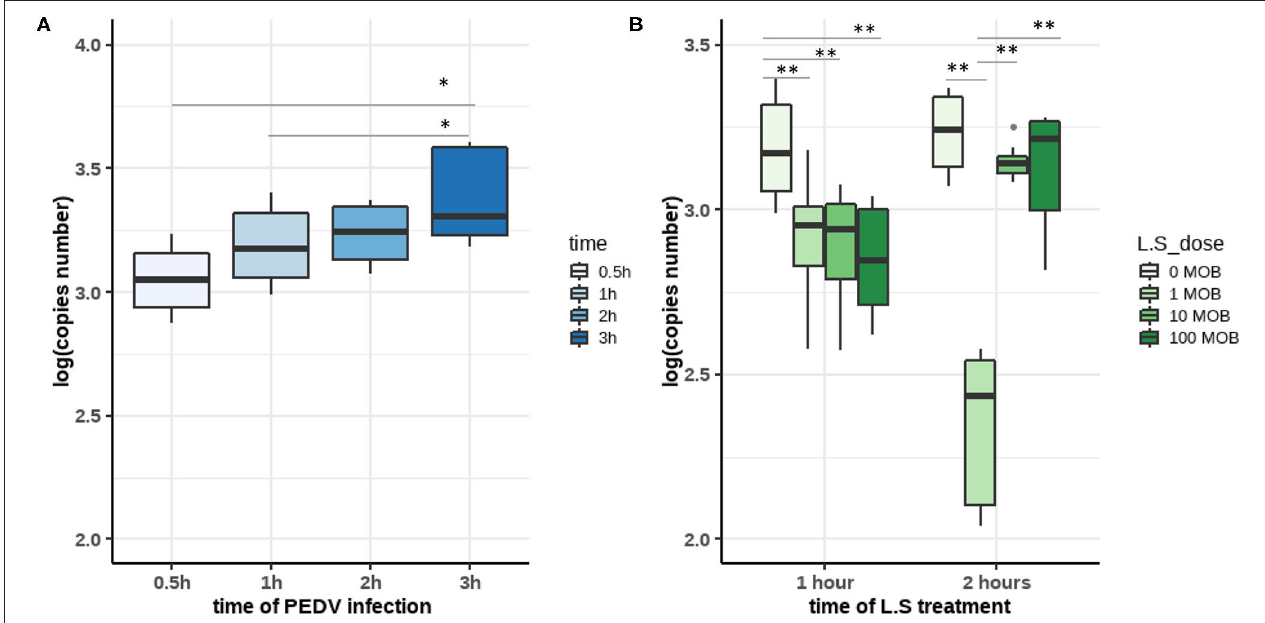
FIGURE 5 | (A) The copy numbers of porcine epidemic diarrhea virus (PEDV) in infected IPEC-J2 cells at different time points. IPEC-J2 cells were infected with the PEDV CV777 strain at 0.1 MOI. After 0.5h, 1h, 2h, and 3h of incubation, viral copies were quantified by qPCR. (B) Lactobacillus salivarius inhibits the infection of IPEC-J2 cells by PEDV. IPEC-J2 cells were treated with different concentrations of L. salivarius (1, 10, and 100 MOI) for 2h before PEDV infection. Then, IPEC-J2 cells were infected with PEDV CV777 at 0.1 MOI for 1 or 2h. The copy numbers of PEDV in each group were detected by qPCR. The differences between the groups were analyzed using the Kruskal–Wallis test. Significant differences are marked with asterisks. *: p < 0.05, **: p < 0.01.